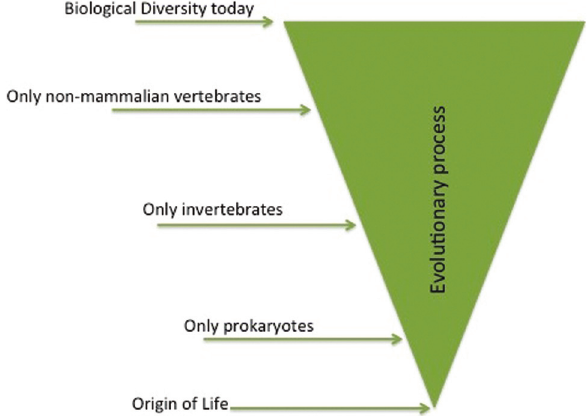
Figure 2 - The relationship between evolution and biology. Ever since the origin of life, evolutionary processes, such as mutation, selection, and ge- netic drift, are responsible for genetic change in natural and laboratory populations. Hence, biology is an instantaneous snap-shot of the dynamic evolutionary axis. This simplified figure illustrates some, of the many, faunal explosions that have took place since the origin of